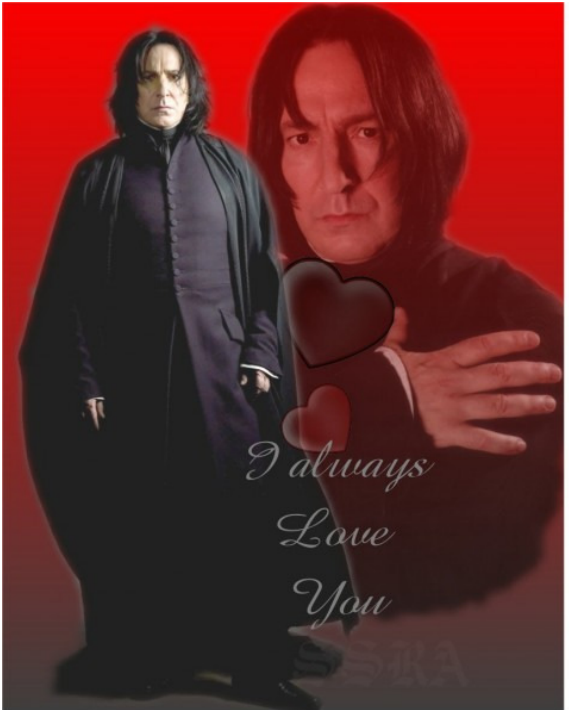
Figure 11. A loving tribute to Snape from Rose